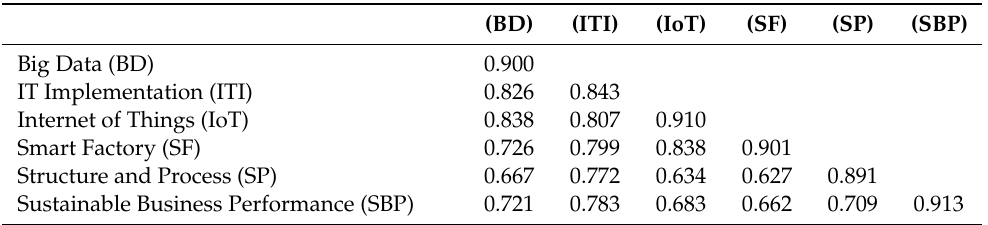
Table 5. Discriminant